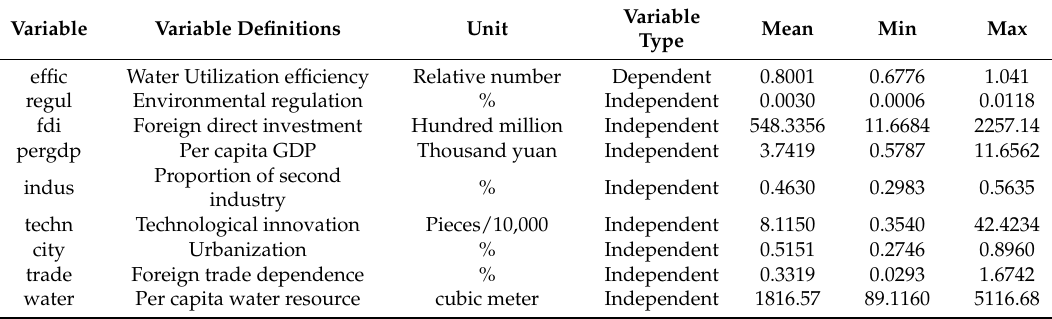
Table 2. Descriptive statistics of water utilization efficiency and influence